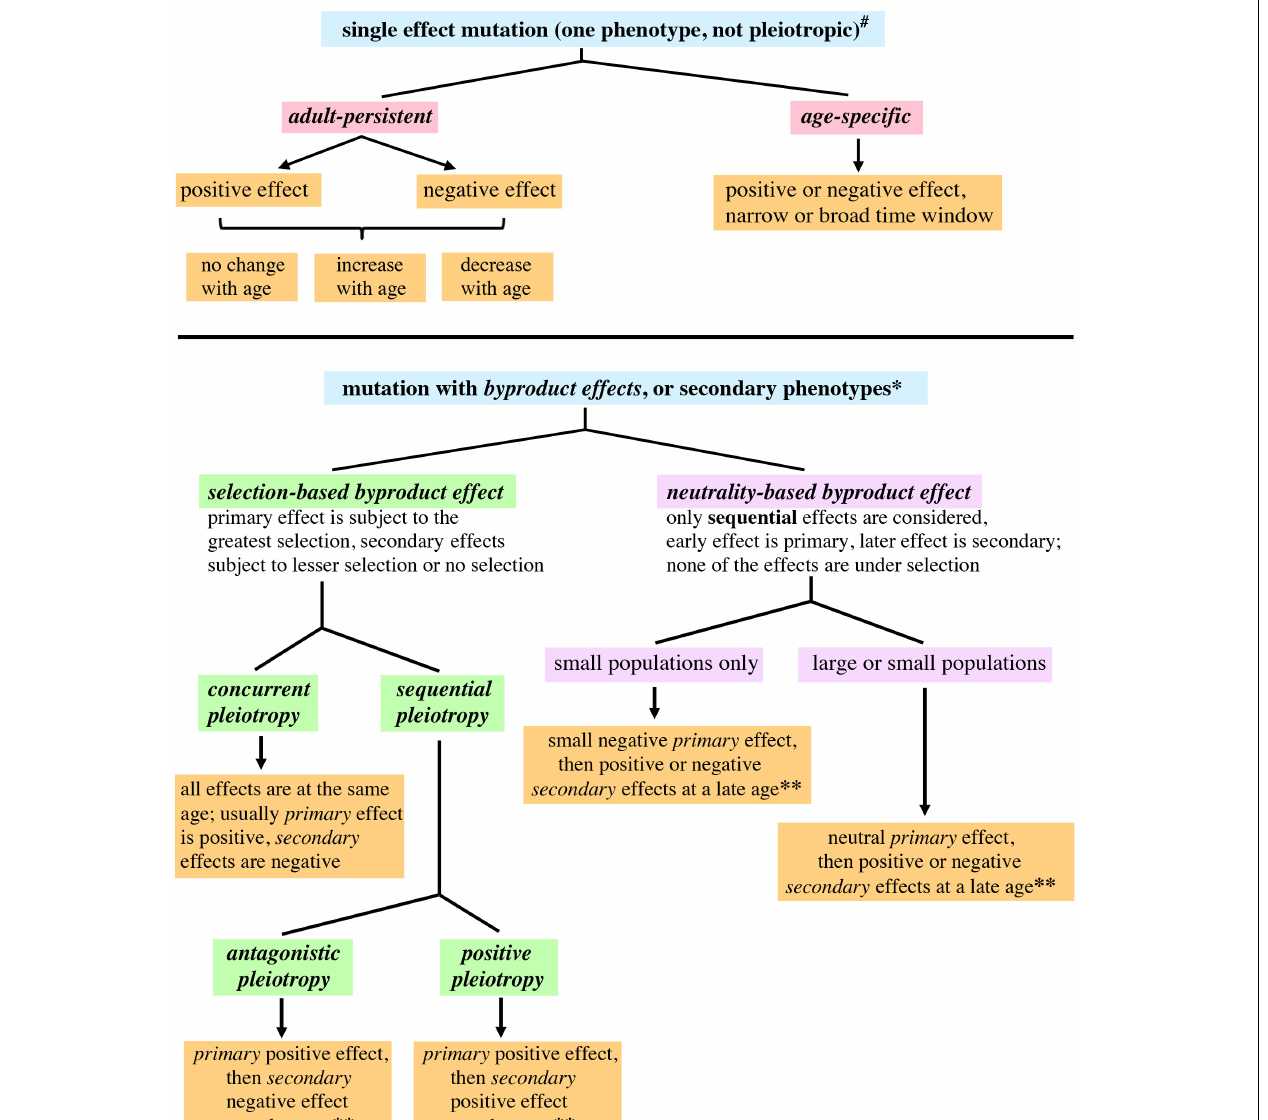
FIGURE 1 | A proposed expansion of genetic terminology allowing application of the terminology to fitness and survival in age-structured populations . A mutation that is pleiotropic or has byproduct effects is defined as having qualitatively different primary and secondary phenotypic effects. Concurrent means the multiple effects of the mutation occur in the same life history stage. Sequential means the primary and secondary effects of the mutation occur in different life history stages. # For single effect mutations, “positive” or “negative” refers to phenotypes affecting fitness; phenotypes affecting survival are relevant to the widest range of ages. ∗ Primary effects are described as positive or negative with regard to fitness. For secondary effects occurring at ages that still have appreciable selection, the secondary effects are also described as positive and negative with regard to fitness. Secondary effects occurring at late ages not subject to selection have a different usage of these terms: “positive” and “negative” describe the effect of a mutation upon survival or a phenotype related to vigor (health span). ∗∗ Only late onset secondary effects would contribute to aging, since secondary effects occurring at younger ages may be subject to